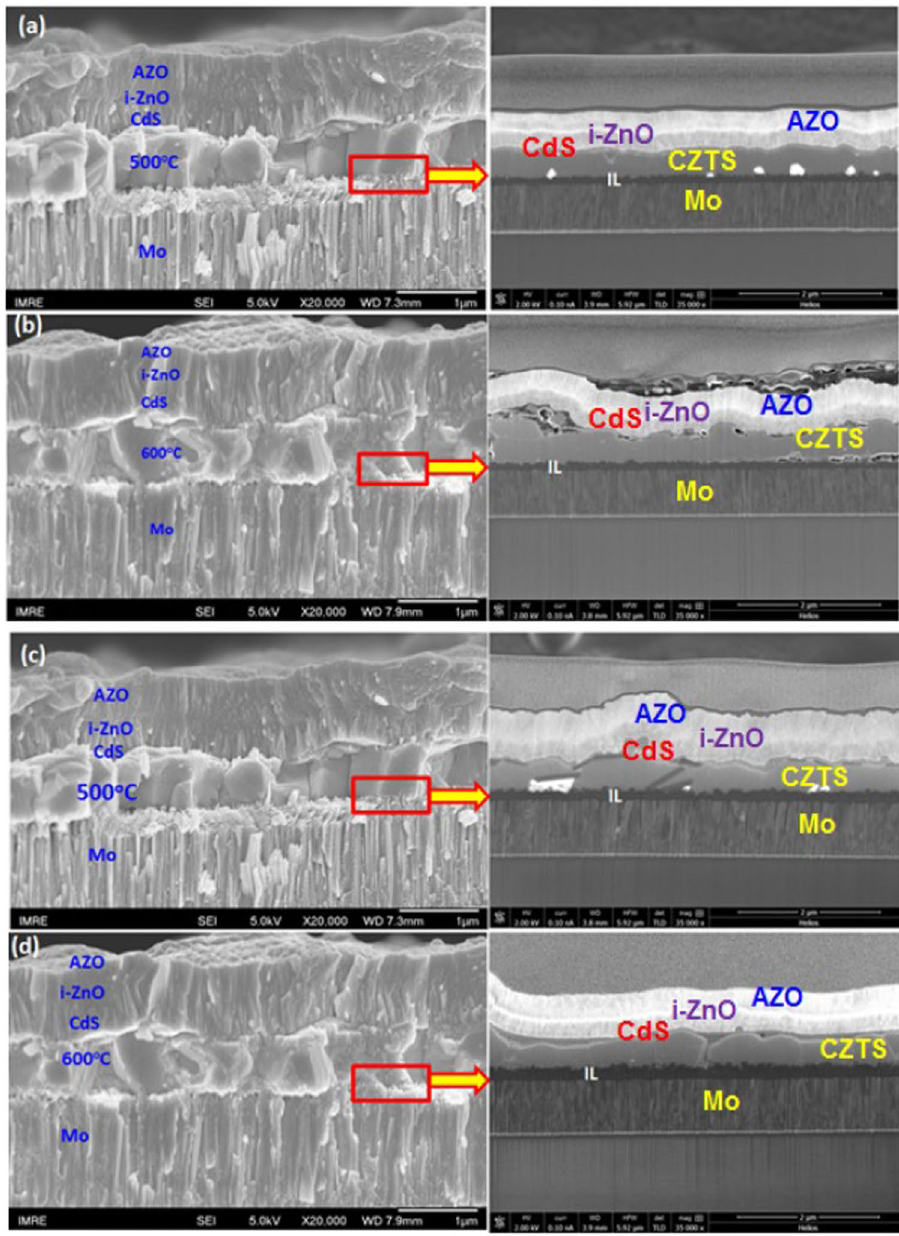
Figure 9. Cross-sectional SEM images of solar cell devices AZO/i-ZnO/CdS/CZTS/Mo/Glass. The CZTS layers (550 nm) sulphurized at ( a ) 500 °C and ( b ) 600 °C. The CZTS layers (650 nm) sulphurized at ( c ) 500 °C and ( d ) 600 °C. The respective cross section of the MoS x interface layer (IL) obtained using focused ion beam milling (FIB) for each of the images in ( a–d ) as highlighted by the red box is shown to the right to determine the IL thickness. The thickness values have been tabulated in Table